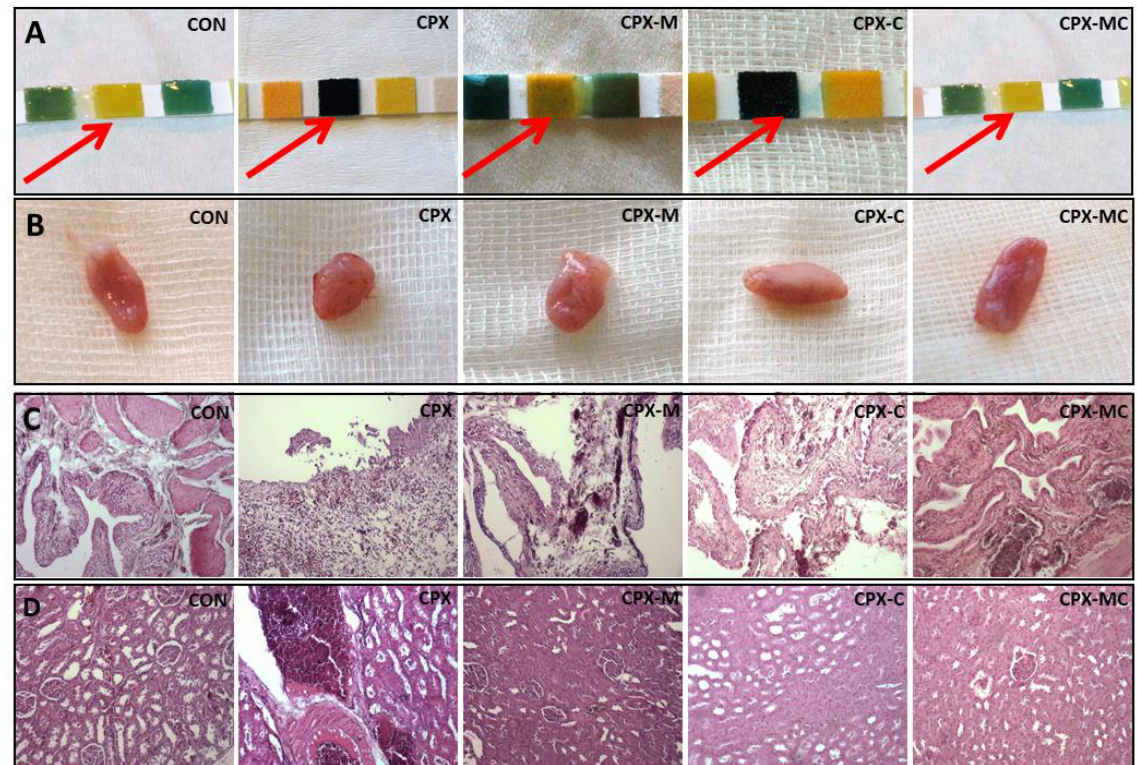
Figure 4. Representative results of dipstick tests for hematuria ( A ), macroscopic images of urinary bladders ( B ), microscopic images of urinary bladders ( C ), and microscopic images of kidneys ( D ). Histological images of bladders and kidneys (hematoxylin-eosin staining, 100 × magnification). On dipstick tests ( A ) red arrows show the area of hematuria detection. In CON and CPX-MC groups no reaction is observed (yellow area), in CPX and CPX-C groups severe hematuria is noticed (the whole area is dark green), and in CPX-M group 1+ reaction is noticed (some green spots on the yellow area). Macroscopic images of urinary bladders ( B ) show no signs of edema in CON, CPX-M, and CPX-MC groups; urinary bladders from CPX and CPX-C groups are significantly swollen. Microscopic images of urinary bladders ( C ) reveal normal urothelium with normal lamina muscularis mucosae (CON group); inflammatory infiltrations, hemorrhages, and ulcerations (CPX group); hyperemia and thinning of the urothelium (CPX-M group); hyperemia, erosions, and thinning of the urothelium (CPX-C group); hyperemia with thinning of the urothelium (CPX-MC group). Microscopic images of the kidney ( D ) reveal hyperemia (CON group); large hemorrhages in the renal tissue (CPX group); swelling of tubules (CPX-M and CPX-MC groups), and atrophy of glomeruli (CPX-C group).